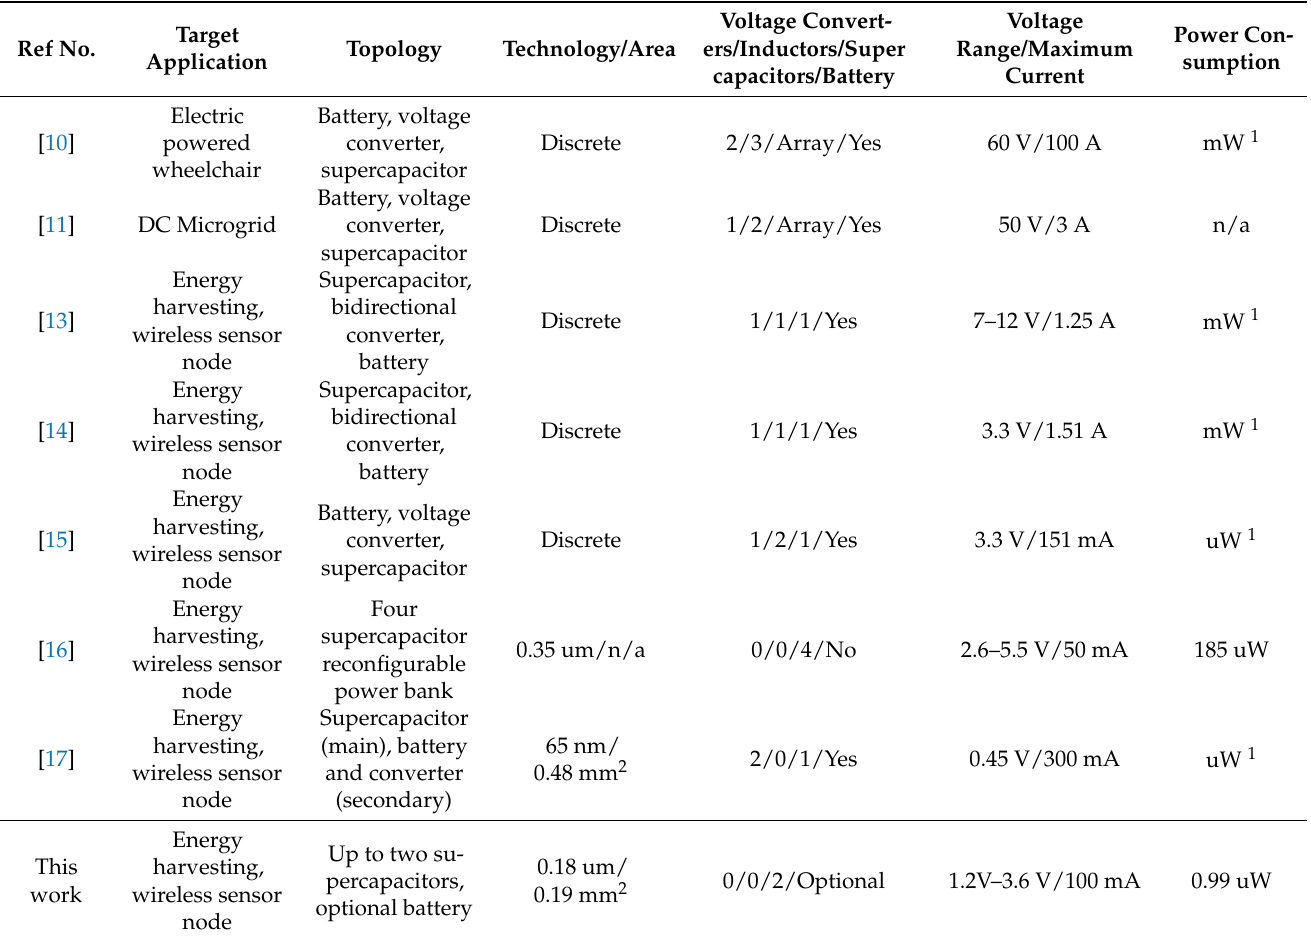
Table 1. State-of-the-art storage units